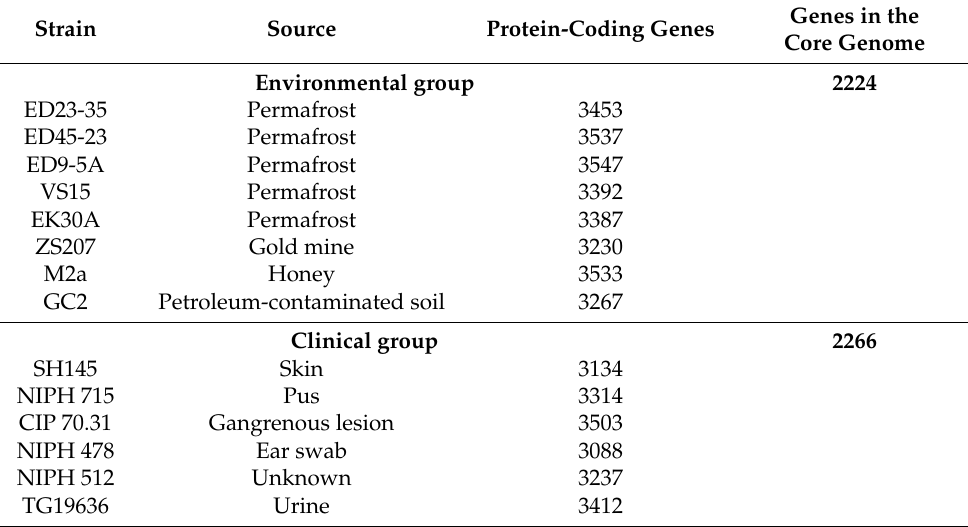
Table 4. Core genomes of clinical and environmental strains of A. lwoffii